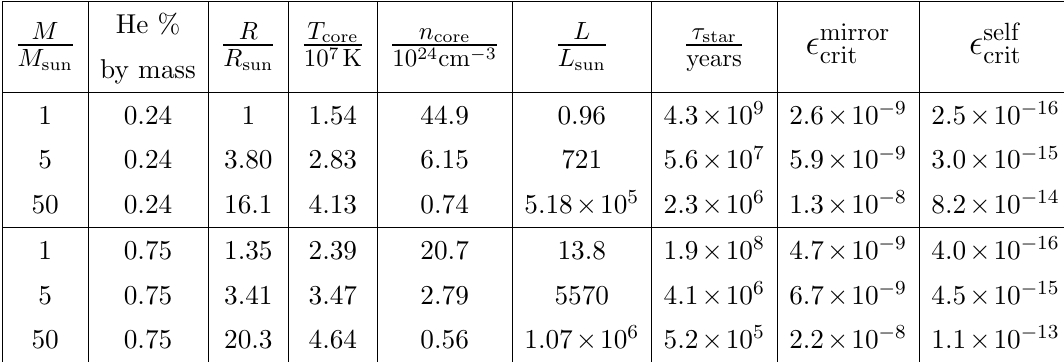
Table 1 . MESA benchmark stars used in the calculations. Listed are the properties of the stars halfway through their main sequence lifetime. In the second column is the percentage helium composition (by mass) at the beginning of the star’s lifetime. The helium mass fraction in the core halfway through the star’s lifetime is 60.5% for the low-helium benchamarks, and 84.9% for the high- helium benchmarks. (cid:28) star is half the main sequence lifetime, the age of the stars at the time we take them as benchmarks. In the last columns, (cid:15) mirror ( (cid:15) self ) is the value of (cid:15) above which mirror capture crit crit is geometric (self-capture becomes geometric within the (cid:12)rst 10% of the star’s lifetime), see section